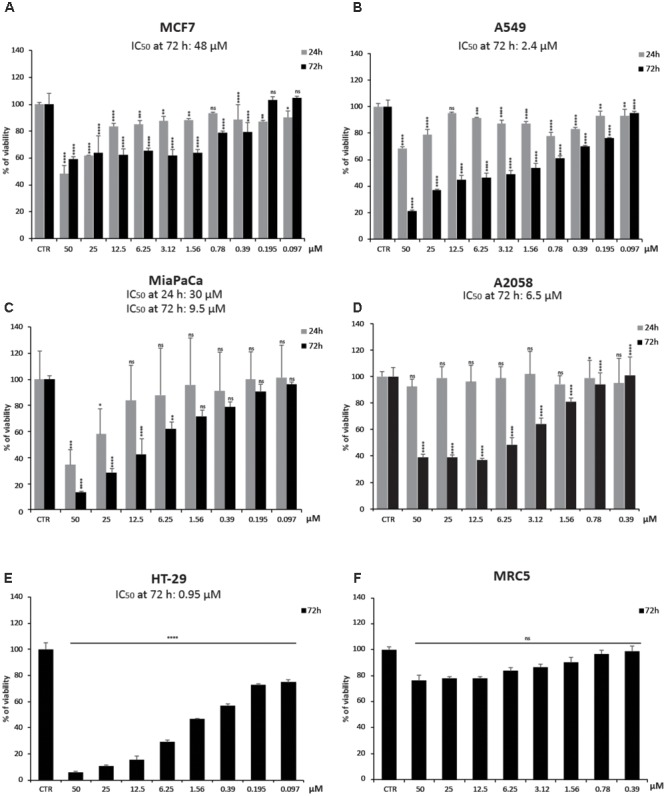
Impact of CHBH on cell proliferation. (A–E) Cell growth rates determined by MTT after treatment with indicated concentrations of CHBH for 24 h (gray bars) and 72 h (black bars) show its anticancer activity. IC50 values show different cellular sensitivity to CHBH; (F) CHBH did not affect cell viability of normal MRC5 cells. Absorbance was read at a wavelength of 570 nm. Values are mean ± SD of biological triplicates. ∗∗∗∗p-value ≤ 0.0001, ∗∗∗p-value ≤ 0.001, ∗∗p-value ≤ 0.01, ∗p-value ≤ 0.05, ns p-value > 0.05 vs. control cells.